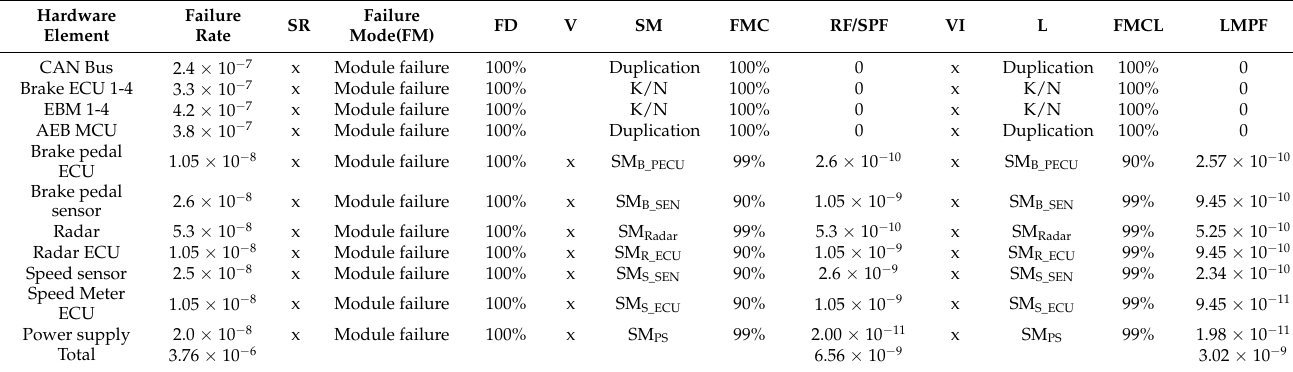
Figure 9. Resulting fault tree for the AEB system hardware architecture in compliance with ASIL D and the hardware overhead constraint. Table 15. FMEDA report for the AEB system with ASIL D safety